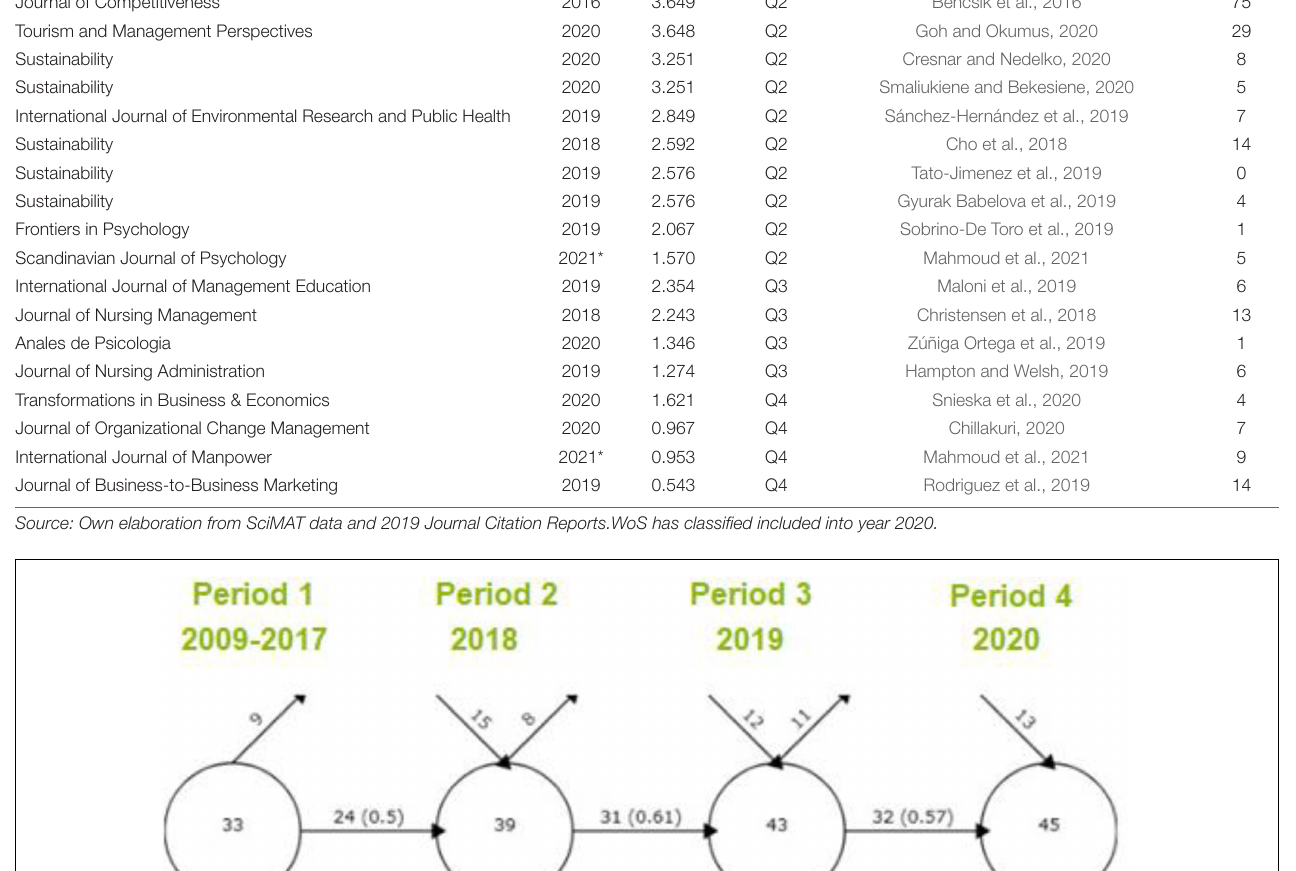
by a lower number of keywords than the rest of periods, which actually have a very similar amount. In the first period, there were 33 keywords, from which, nine were no longer used in the following ones. More than half of the words used (0.5) in this period were also transferred to the second one. For the second period, 15 additional words were introduced, summing up to 39 total keywords. Again, eight keywords disappeared and 31 transitioned to the next period, representing almost three fourths (0.61) of the total word count in 2019, being higher than the common keyword proportion of the change from period 1 to period 2. In the third period, 12 keywords were included in the topic research, adding up to 43 total keywords. Then, 32 keywords were included in the last period and 11 keywords were lost and will not be used in the following period. In the last period 13